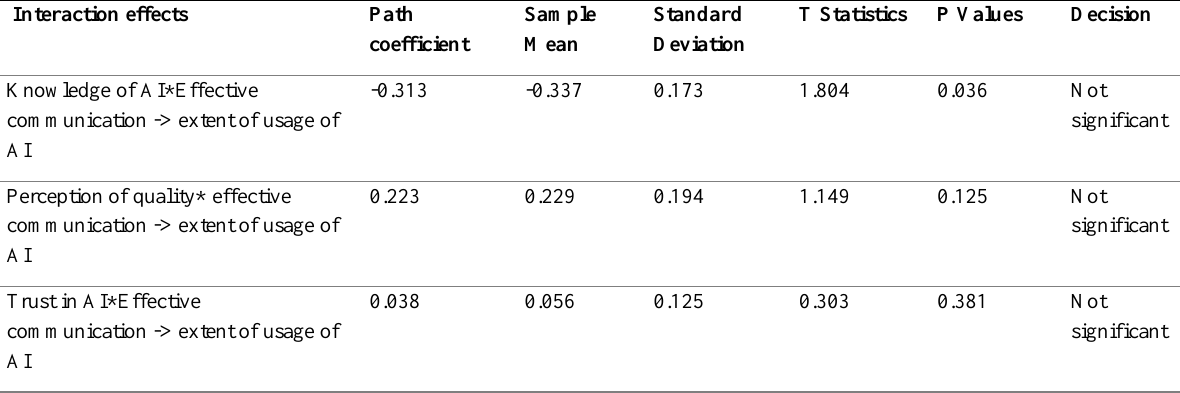
Table 10: Moderation